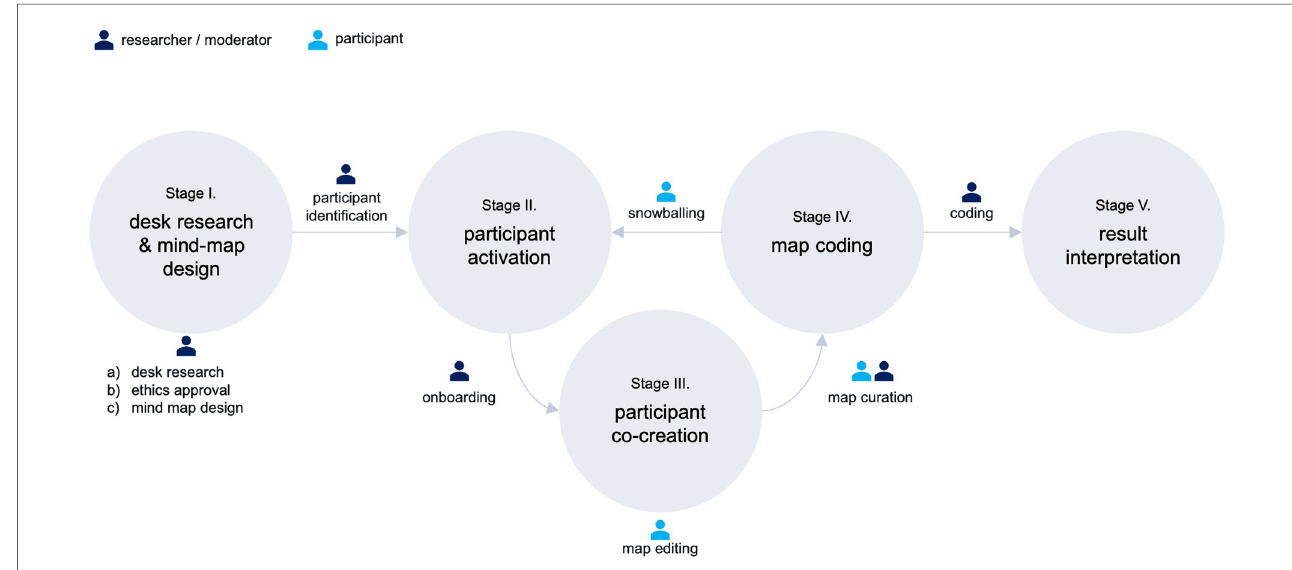
FIGURE 1 Flowchart of research activities.